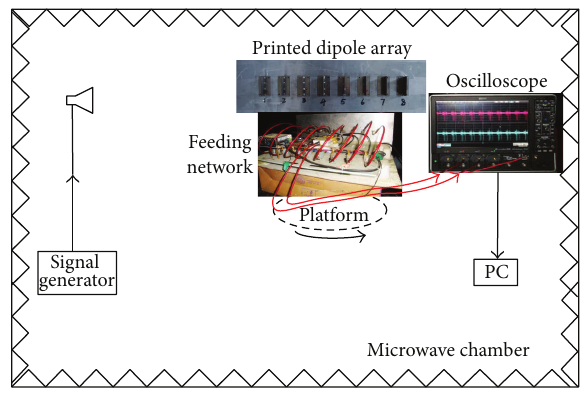
Figure 9: Block diagram of the experiment setup.